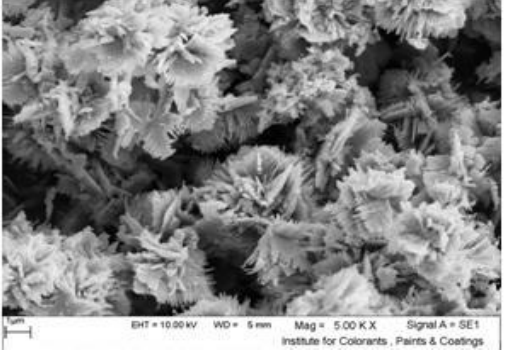
Fig. 2 . The effect of nano-CuO on ∆ G 0 temperatures at pH=7.4 .